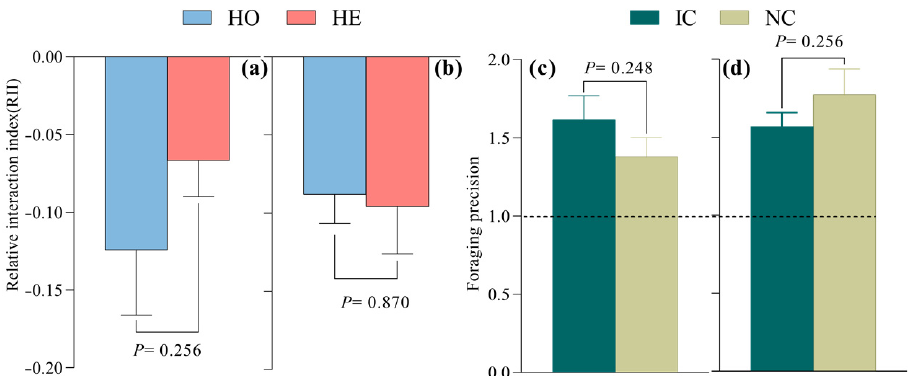
Figure 2. Effect of nitrogen distribution pattern on the relative interaction index and root foraging precision of maize. ( a ) Relative interaction index at flowering stage. ( b ) Relative interaction index at mature stage. ( c ) Foraging precision at flowering stage. ( d ) Foraging precision at mature stage, HO: Nitrogen homogenization supply, HE: Nitrogen heterogeneous supply, IC: Intraspecific competition, NC: No competition, the same as below.